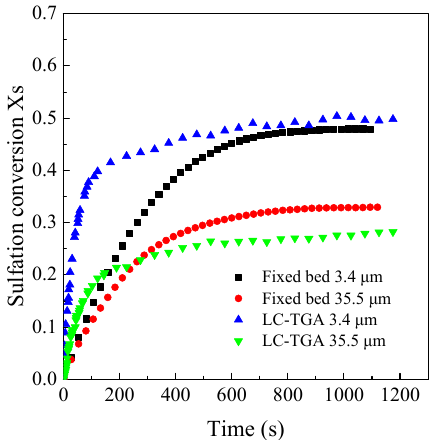
Figure 7. The comparison of sulfation conversion in the LC-TGA and the fixed bed reactor (Samcheok limestone, 850 °C, 2000 ppm).